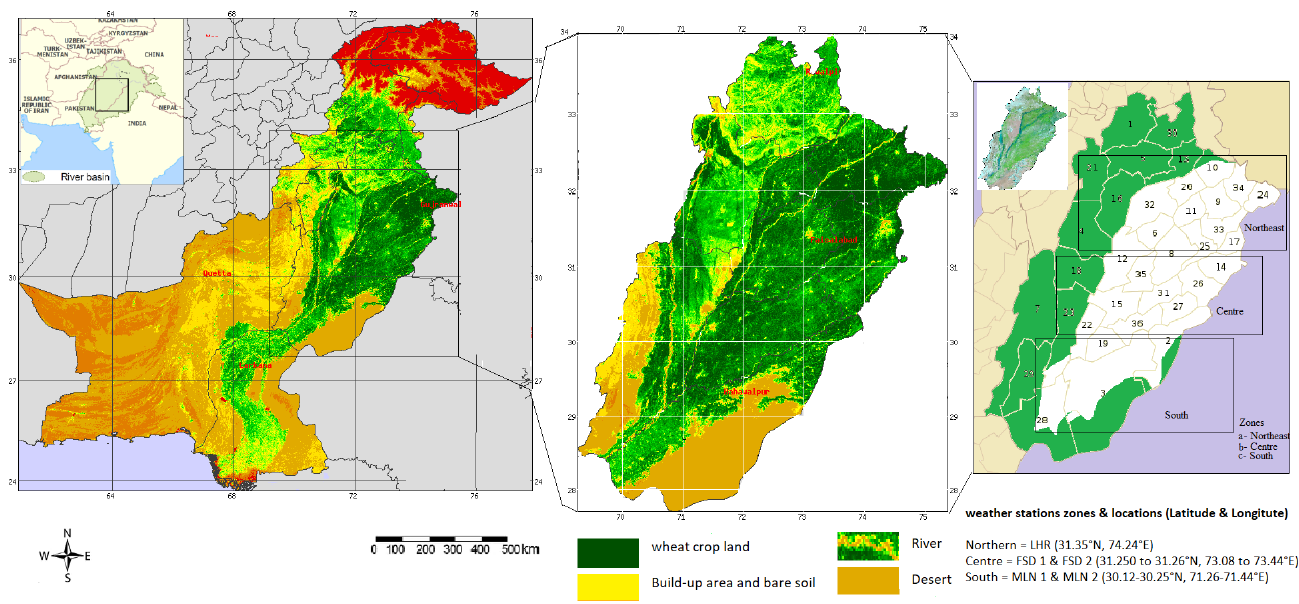
Figure 1. Geographical position with a sinusoidal grid over h23/v05, h24/v05, and h24/v06 mapped plates and pixel size with an approximately 1 km land product defined and coordinated (27.41 – 34.02°N, 69.15 – 75.23°E) with weather station zones located in the northern, central and southern parts of the Punjab region.